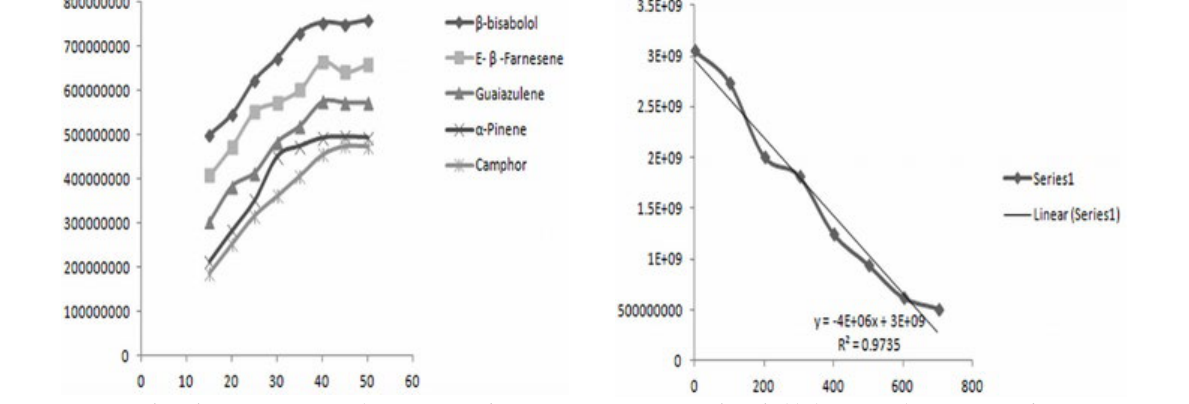
Fig. 2. Effect of extraction time on the extraction efficiency. (X= min, Y=area peak)